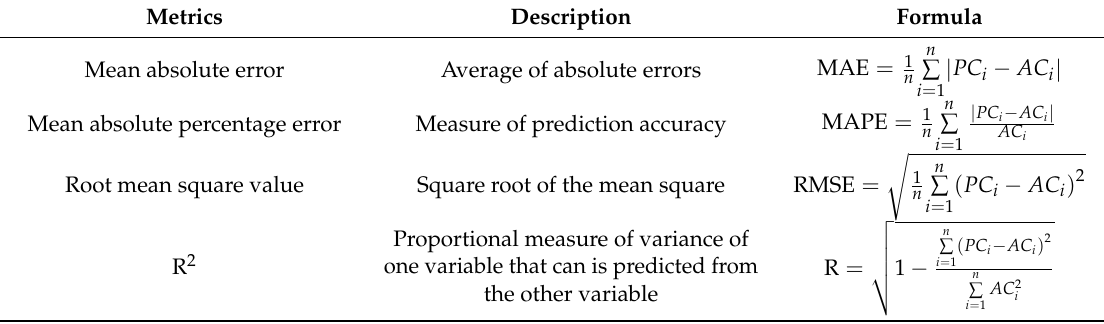
Table 6. Performance metrics.